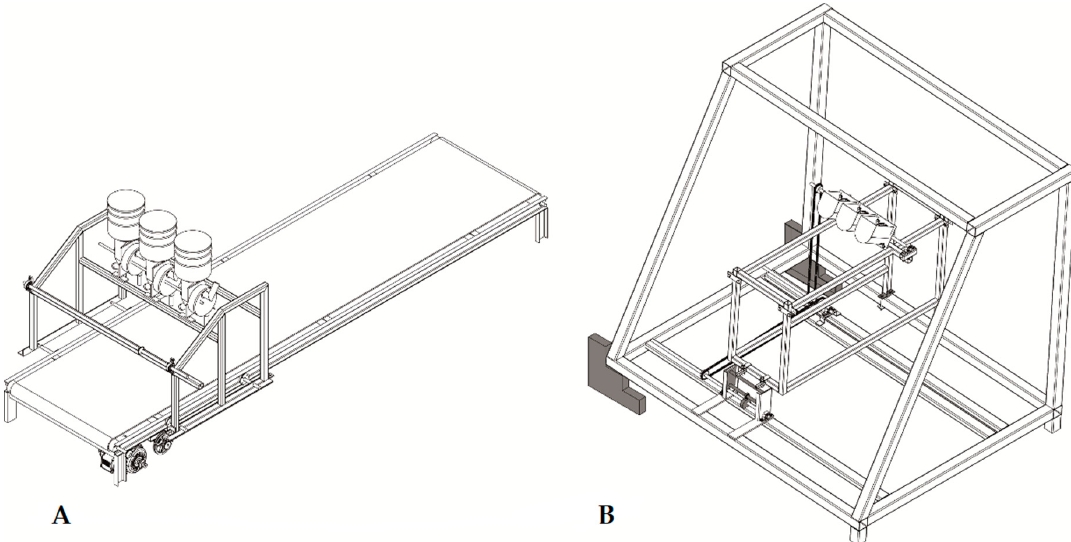
Figure 1. Test-bench setup with a fixed frame over a conveyer belt ( A ) and the seed meters mounted on seeder-like structure that facilitates adding vibration and sideways inclination ( B ).